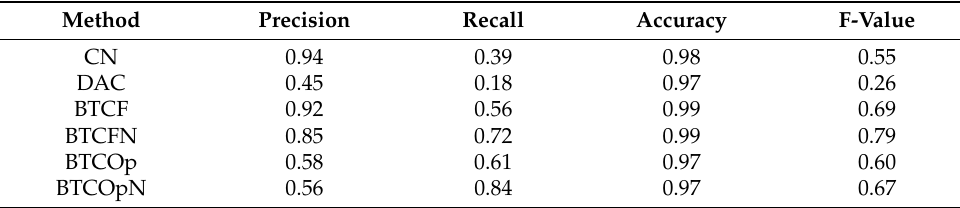
Table 7. Performance indicators for maxigrams of actual thermal sequences using different processing techniques.